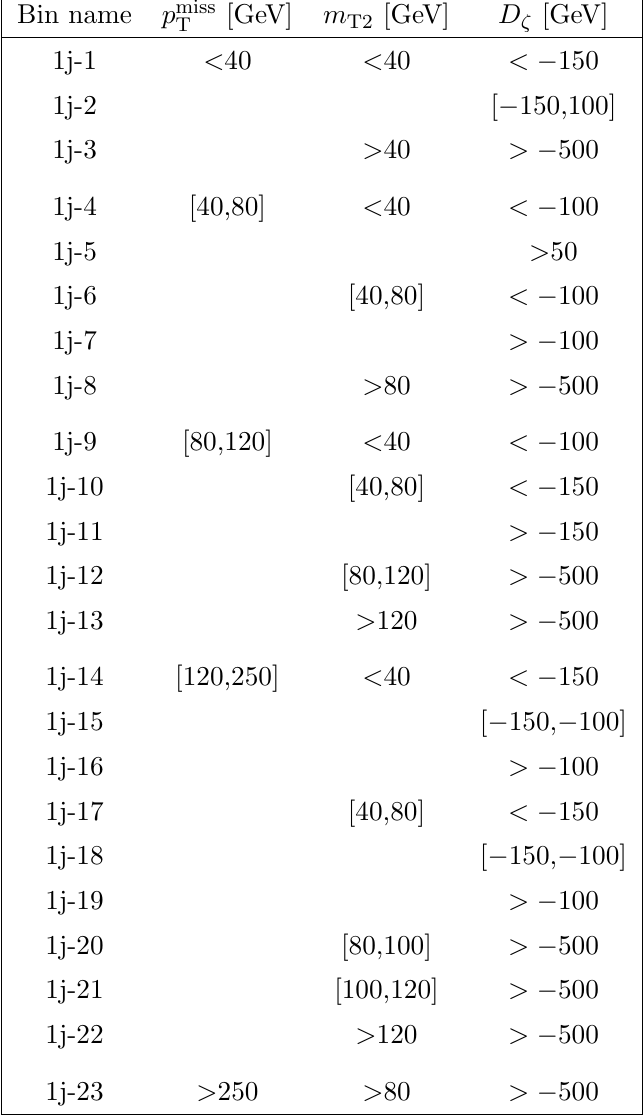
h and (cid:22)(cid:28) h (cid:12)nal